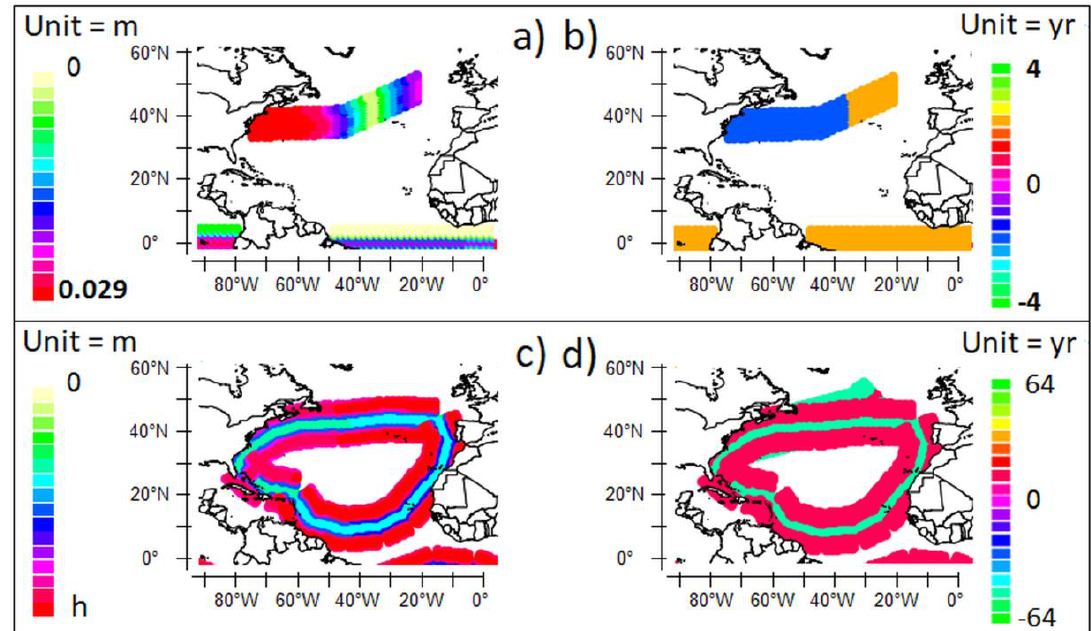
Figure 1. The perturbation η of the sea surface height obtained by solving the equations of motion of the north Atlantic Gyral Rossby Waves (GRWs) dragged by the wind-driven current -a) amplitude of the 8-year period GRW: the apparent half-wavelength of the GRW extends from where the boundary current leaves the North American coast to the drift current [18] -b) the phase – c) amplitude of the 128-year period GRW: the apparent half-wavelength of the GRW winds two turns around the gyre [17] – d) the phase.